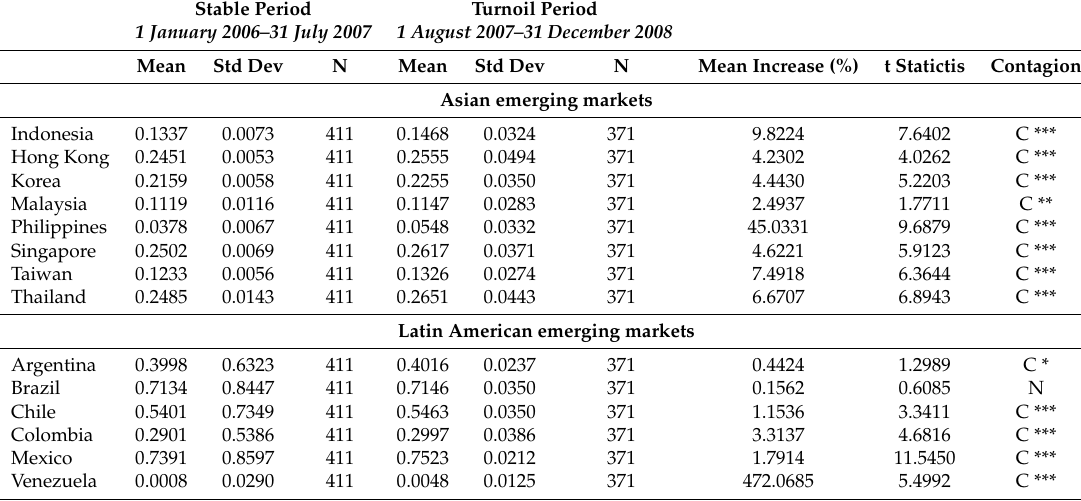
Table 11. Results of contagion test in emerging stock markets: The US subprime crisis in